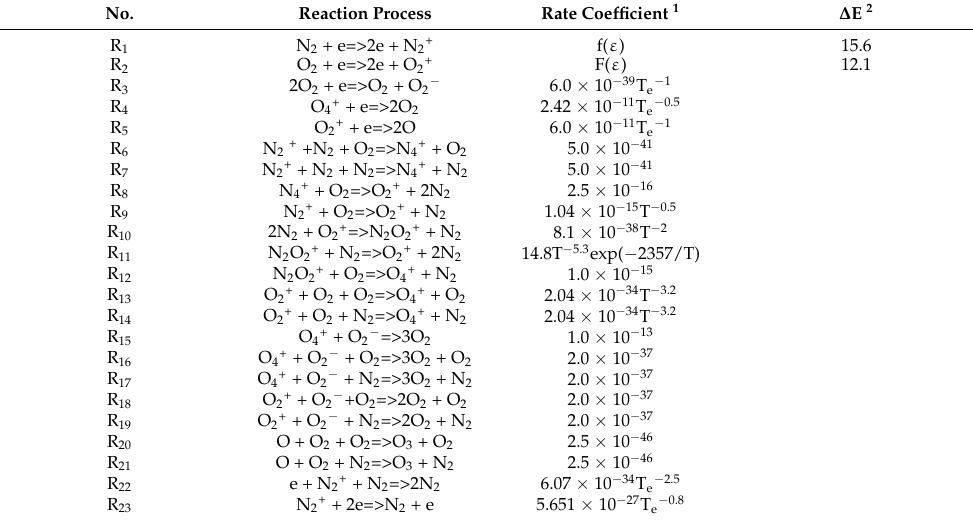
Table 1. Air plasma gas–phase